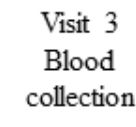
Figure 1. The scheme of the patient’s visits.